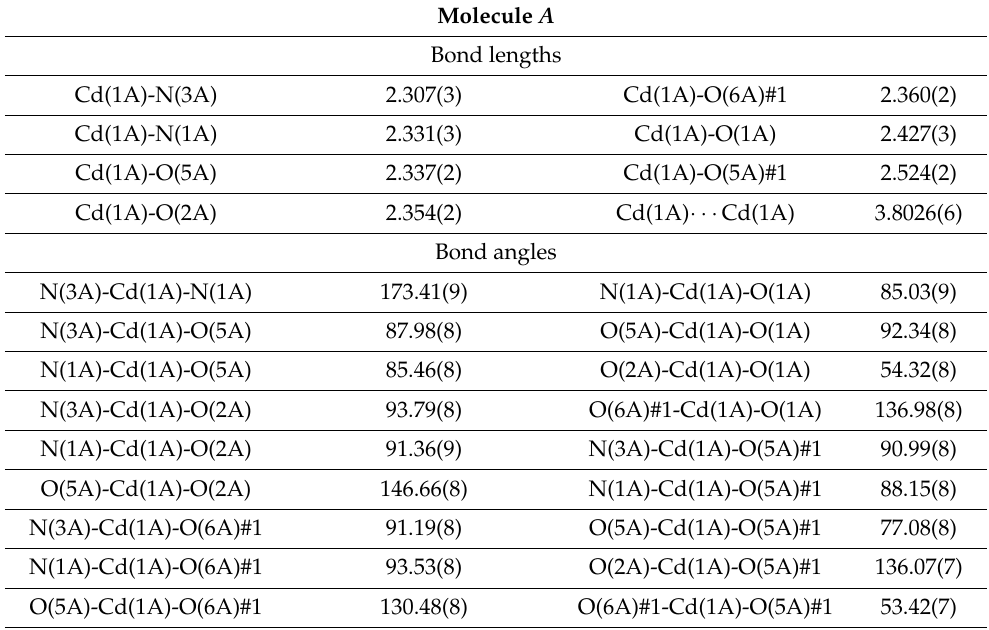
Table 5. Bond lengths (Å), bond angles ( ◦ ) and intramolecular π · · · π interactions of 4